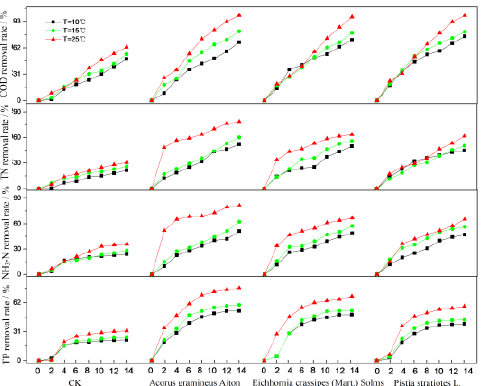
Figure 6. Purification effect of three kinds of wetland vegetation under different temperatures.